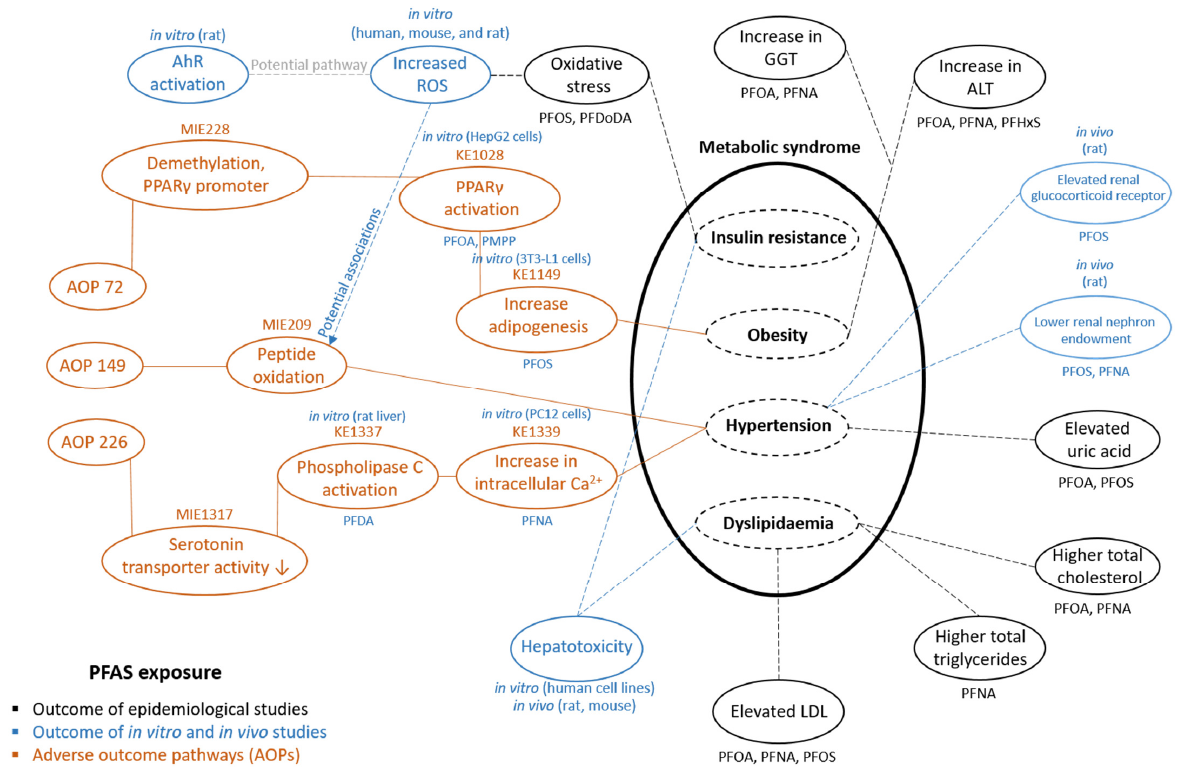
Figure 3. Identified connections between outcomes of epidemiological, in vivo, and in vitro studies on per- and polyfluoroalkyl substances (PFAS) and adverse outcome pathways (AOPs) from AOP-Wiki with a focus on the components of metabolic syndrome.